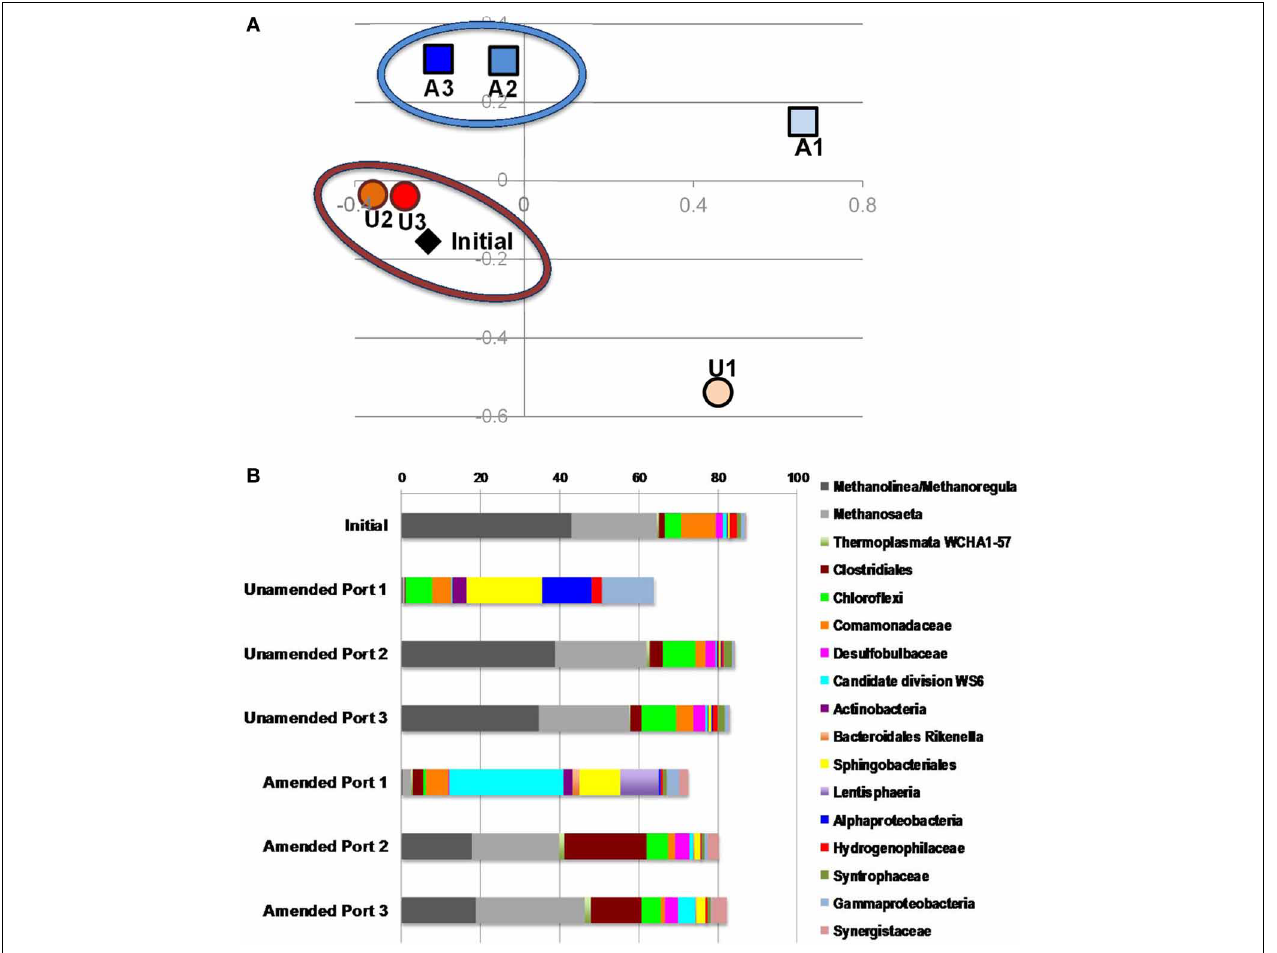
FIGURE 6 | Microbial community analysis. (A) Non-metric multidimensional scaling (NMDS) analysis of 16S rRNA gene pyrosequences comprising microbial communities in initial MFT (black diamond) and MFT samples taken from unamended (U; orange circles) and amended (A; blue squares) column ports. Numbers indicate the ports (Figure 1 in Siddique et al., 2014), with port 1 accessing cap water and